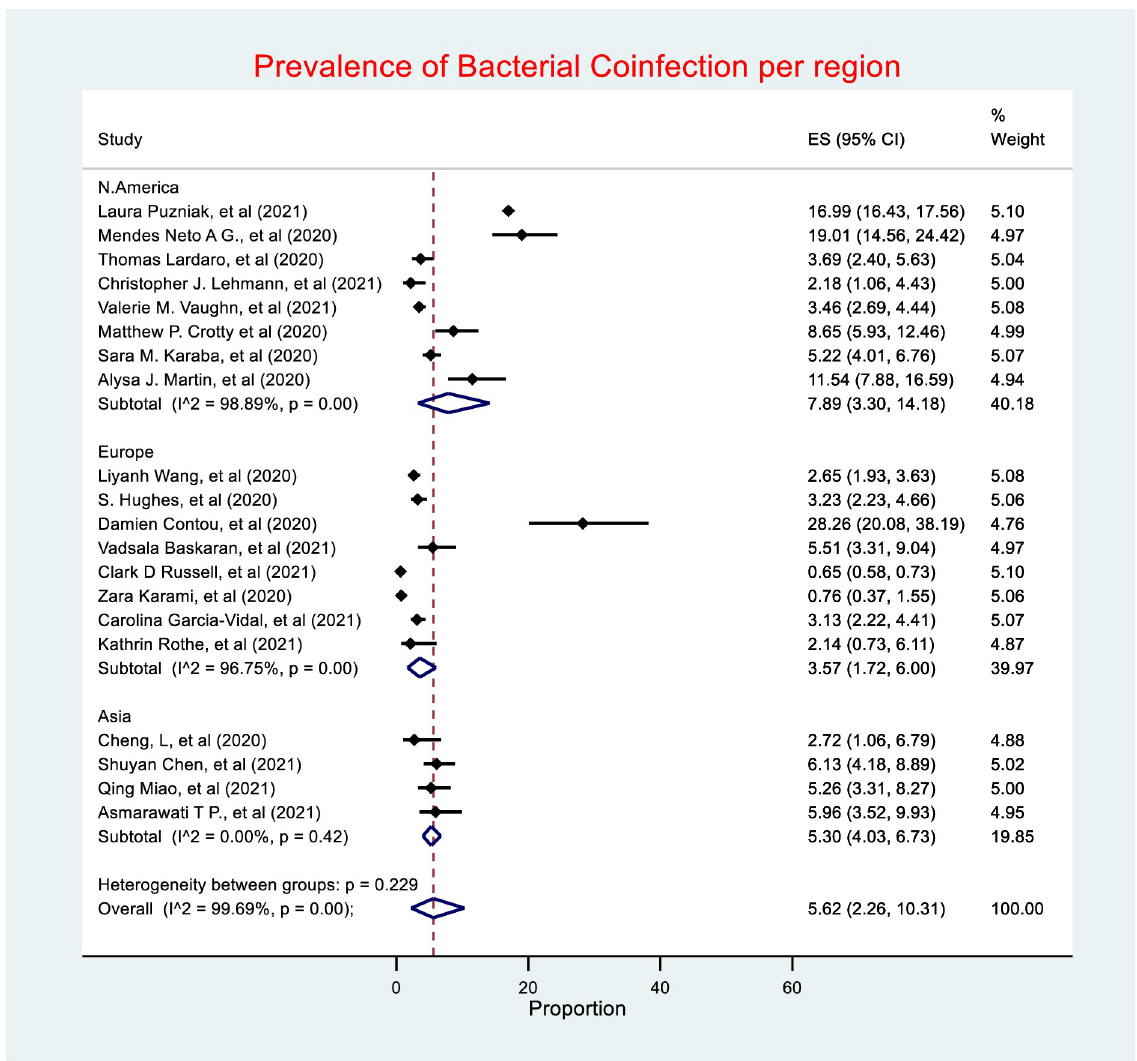
Fig 4. Prevalence of bacterial coinfection by